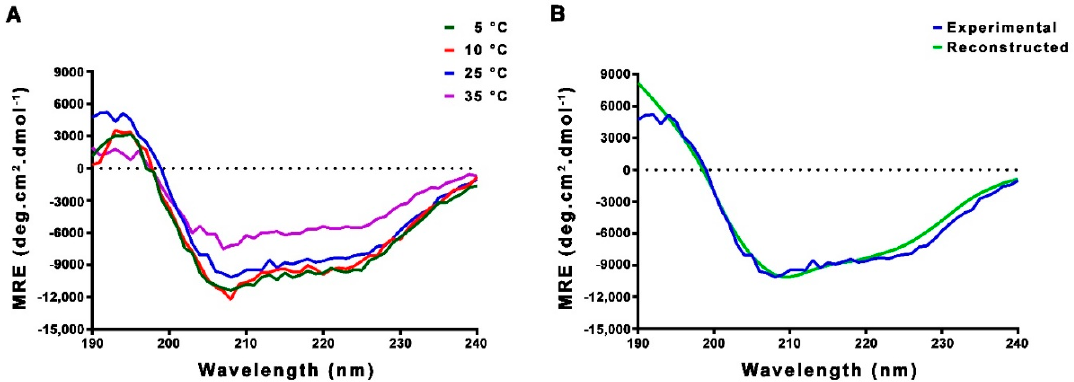
Figure 1. ( A ) CD spectra of FL-Nrf2 recorded at 5, 10, 25, and 35 °C. ( B ) Deconvolution of FL-Nrf2 CD spectrum at 25 °C using the CONTINLL program in DichroWeb, with protein reference data set 4 (optimized for 190–240 nm). The NRMSD between the experimental and reconstructed CD data is 0.13.